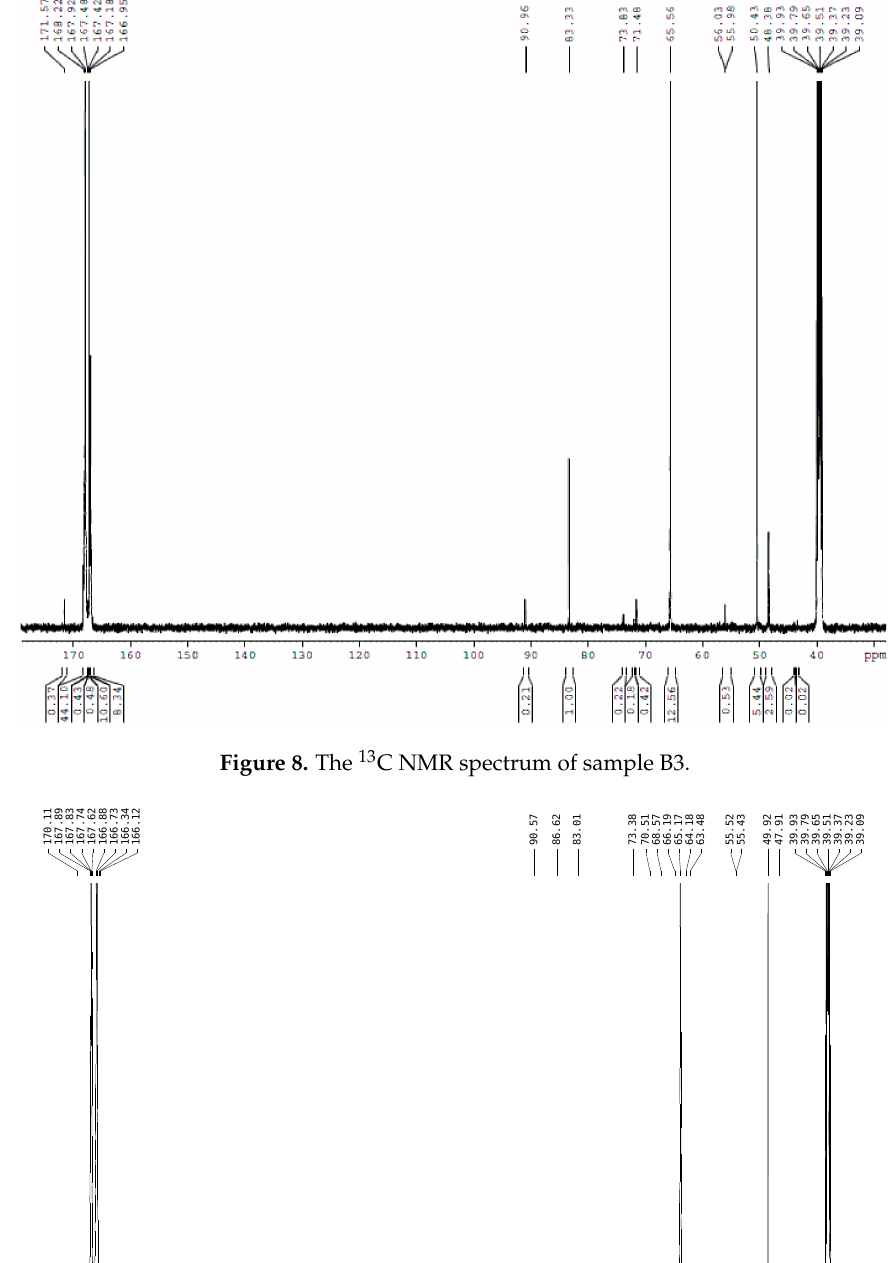
Figure 7. The 13 C NMR spectrum of sample B2.